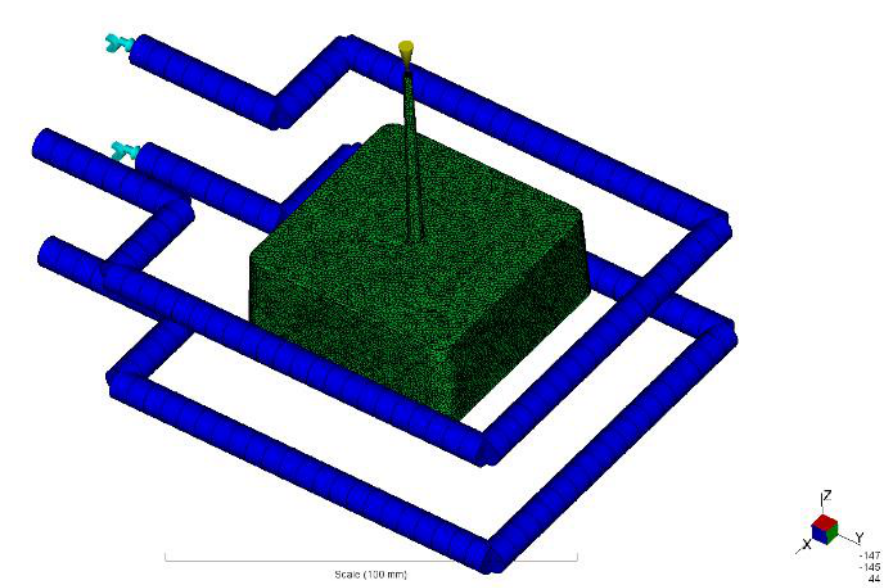
Figure 7. Model in AMI ® 2019 with the cooling system (blue) and melt entrance (yellow cone) .